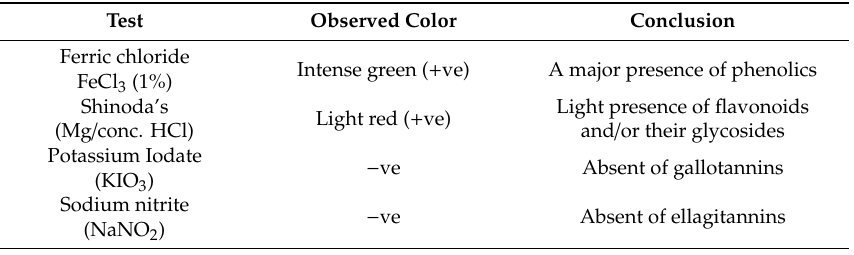
Table 1. Phenolic constituents of the C. vitellina extract.